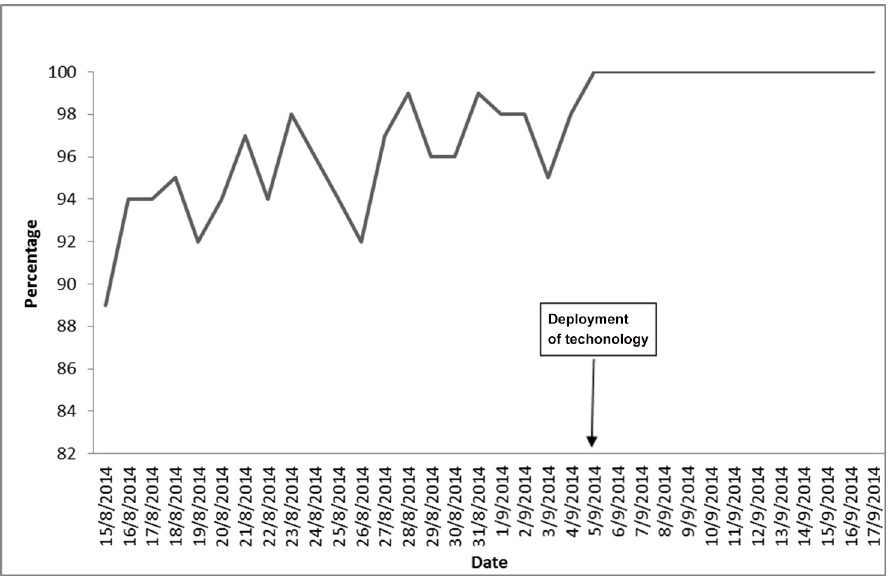
Fig 4. Trend of contact follow-up before and after deployment of Mobile